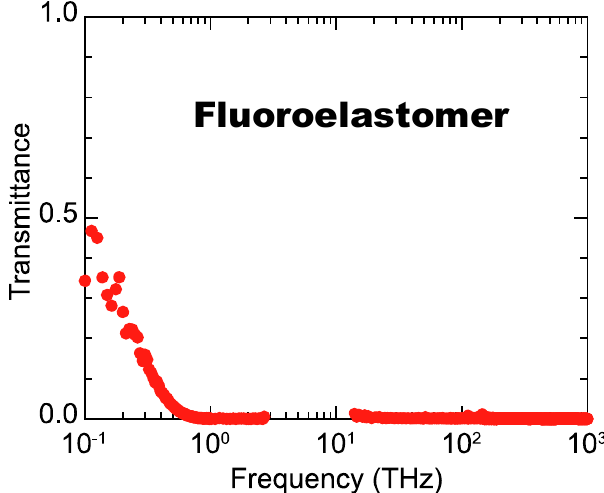
Figure 2. Transmittance spectrum of a 1-mm thick FKM composite ranging from the terahertz to the visible light regime. Reproduced from M. Okano et al. Sci. Rep. 6 , 39079 (2016) [25]. Licensed under CC BY 4.0.